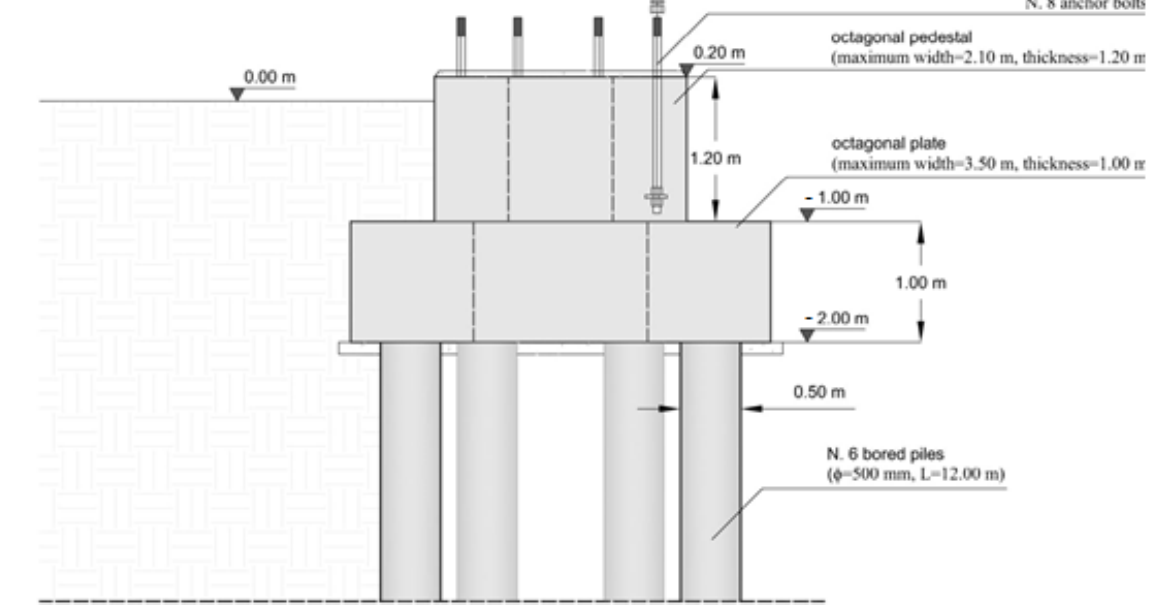
Figure 13. Profile view of the basement.